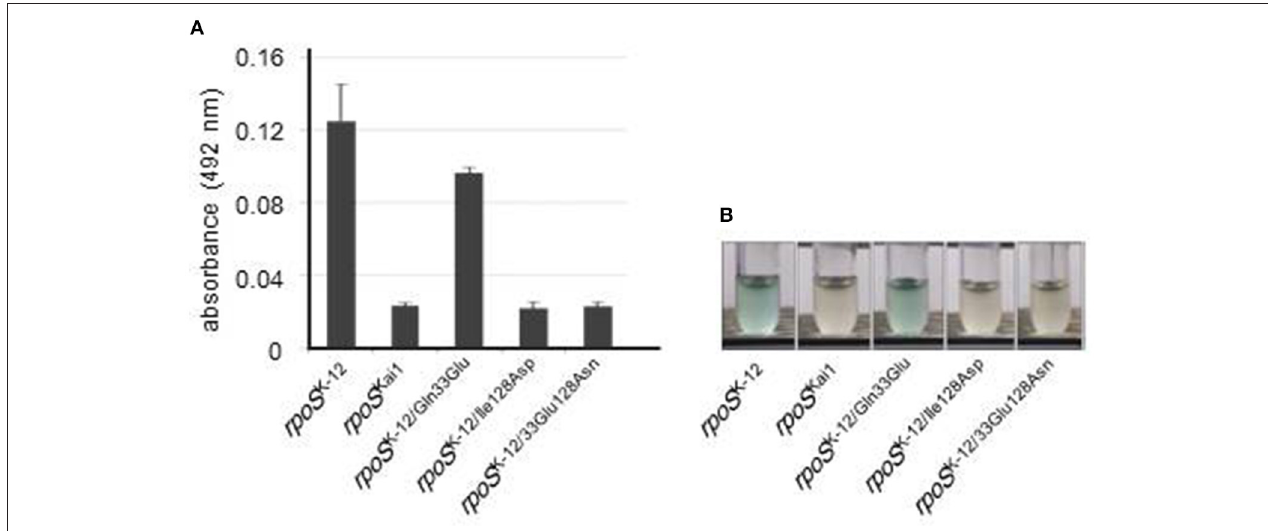
FIGURE 3 | RpoS dysfunction via substitution at residue 128. Reporter assays with β -galactosidase were performed for evaluation of RpoS function using a strain in which intact rpoS was deleted and an osmY promoter- lacZ transcriptional fusion was located on a single copy λ -prophage and using each rpoS variant. (A) β -Galactosidase activity was measured in the presence of ONPG, a substrate of β -galactosidase, using spectrophotometry. Mean values are shown ( n = 3). Error bars represent standard deviations. (B) β -Galactosidase activity was visualized using X-gal, a substrate of β -galactosidase that produces the insoluble blue dye indigo. The experiment was conducted thrice, and representative images are shown. The statistical significance of the differences is tabulated in Table S3.